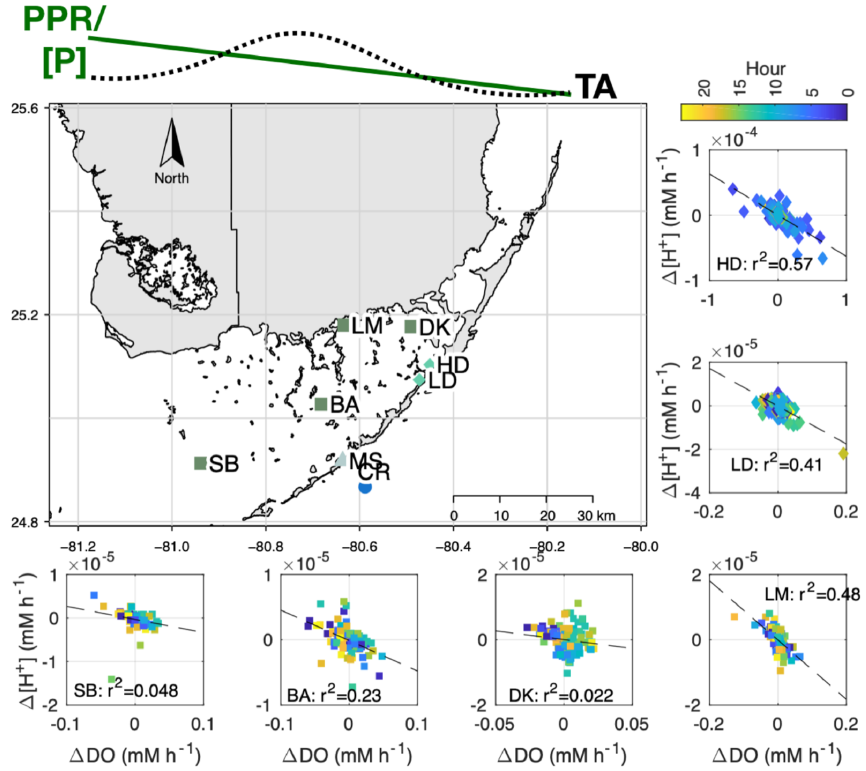
Figure 9. Map showing (cid:49) [ H + ] vs. (cid:49) DO relationship for sites associated with LTER (SB, BA, DK, and LM) and the present study (high density – HD – and low density – LD). At the top of the figure, we present the general east-to-west pattern in seagrass primary productivity (PPR), phosphorus content ([P]; Fourqurean et al., 1992), and TA (Millero et al., 2001) within Florida Bay. All LTER sites failed to meet the assumptions for a test of slope significance (gvlma package in R), so we simply report the R 2